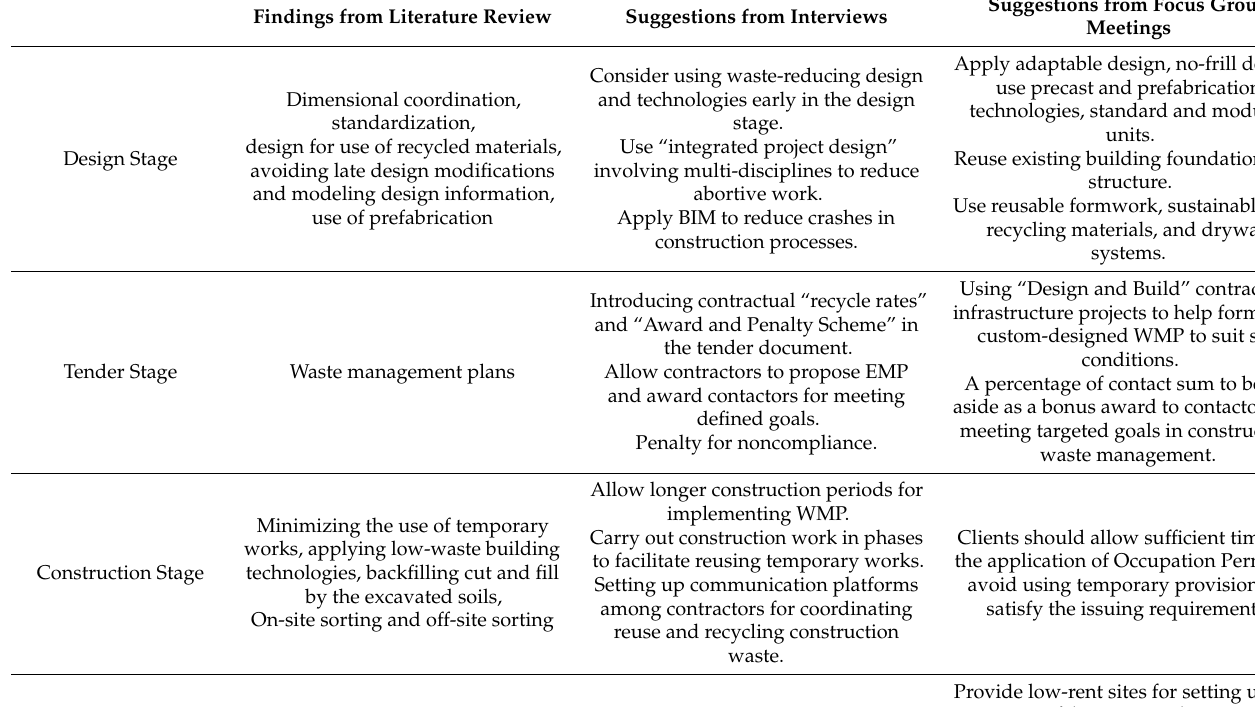
Table 3. Suggestions for improving construction waste